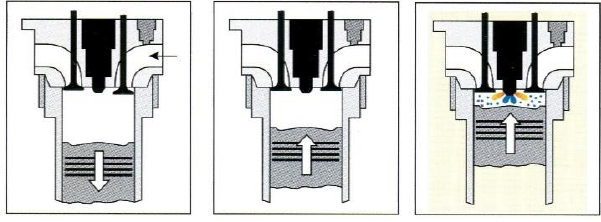
Fig. 6 Schematic drawing of direct dual-fuel injection engine work (repro- duced from